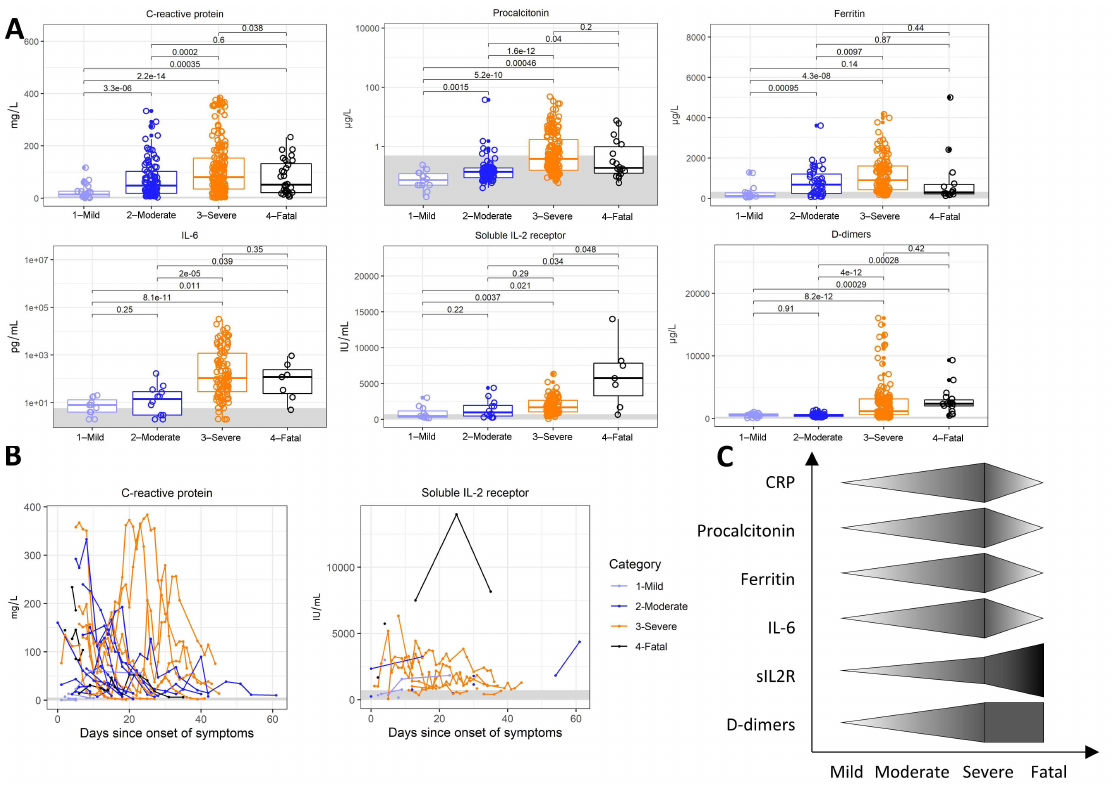
Figure 1. Inflammation. ( A ) C-reactive protein (CRP), procalcitonin, ferritin, interleukin 6 (IL-6), soluble IL-2 receptor (sIL2R), and D-dimers in patients with mild, moderate, severe, and fatal courses of the disease. ( B ) Temporal changes in C-reactive protein and soluble IL-2 receptor levels in patients with mild, moderate, severe, and fatal courses of the disease over time. ( C ) Comparison of the trends between individual parameters shown in ( A ). Boxes depict the median and first and third quartiles, and whiskers show the 2.5th and 97.5th percentiles. Each symbol represents a unique measurement. Multiple measurements at di ff erent time points are included for all patients. Values shown are the Student’s t -test p -values with Holm’s multiple comparison adjustments. Where available, a healthy reference range for adult males is shown in light